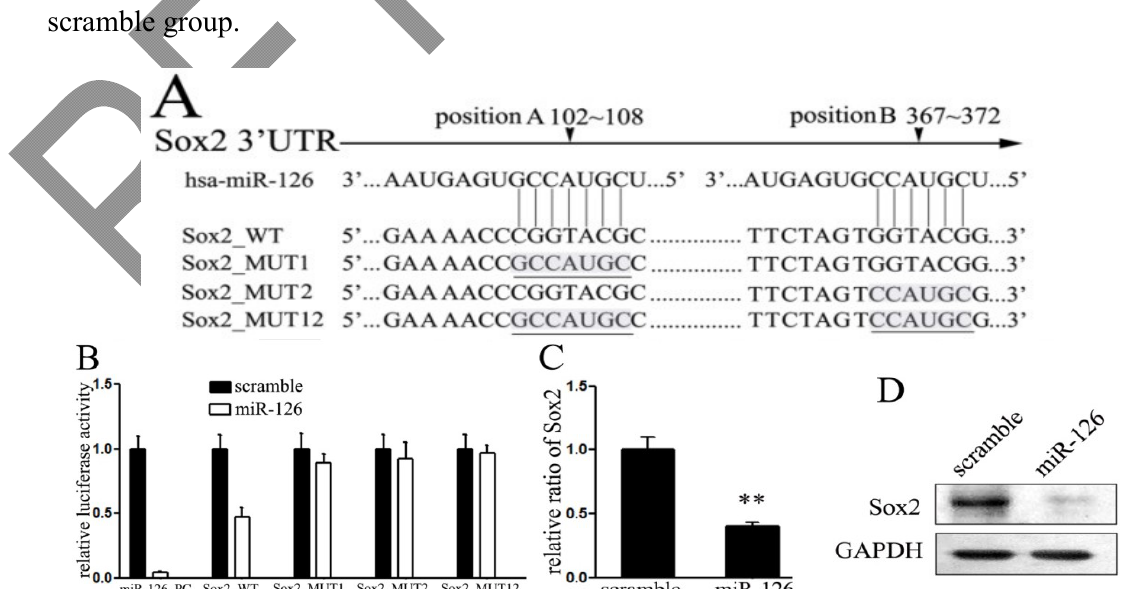
Figure 3. miR-126 targets the Sox2 gene in MG-63 cells. ( A ) Schematic representation of Sox2 3'UTR showing putative miRNA target sites. There exist two putative binding sites in the 3'UTR of miR-126; ( B ) Relative luciferase activity of the indicated Sox2 reporter construct in MG-63 cells, co-transfected with miR-126 mimics or scramble mimics, is shown. In cells co-transfected with pGL3-Sox2 3'-UTR vector and miR-126 mimic, the luciferase activity was suppressed relative to mutant construct groups, and the one in both binding sites mutant (MUT-12) showed the lowest activity; and ( C , D ) Quantitative RT-PCR and Western blot assays were performed to detect the expression of Sox2 upon transfection with miR-126 mimics or scramble mimics. The expressions of mRNA and protein were suppressed upon transfection with miR-126. ** p < 0.01 compared with scramble